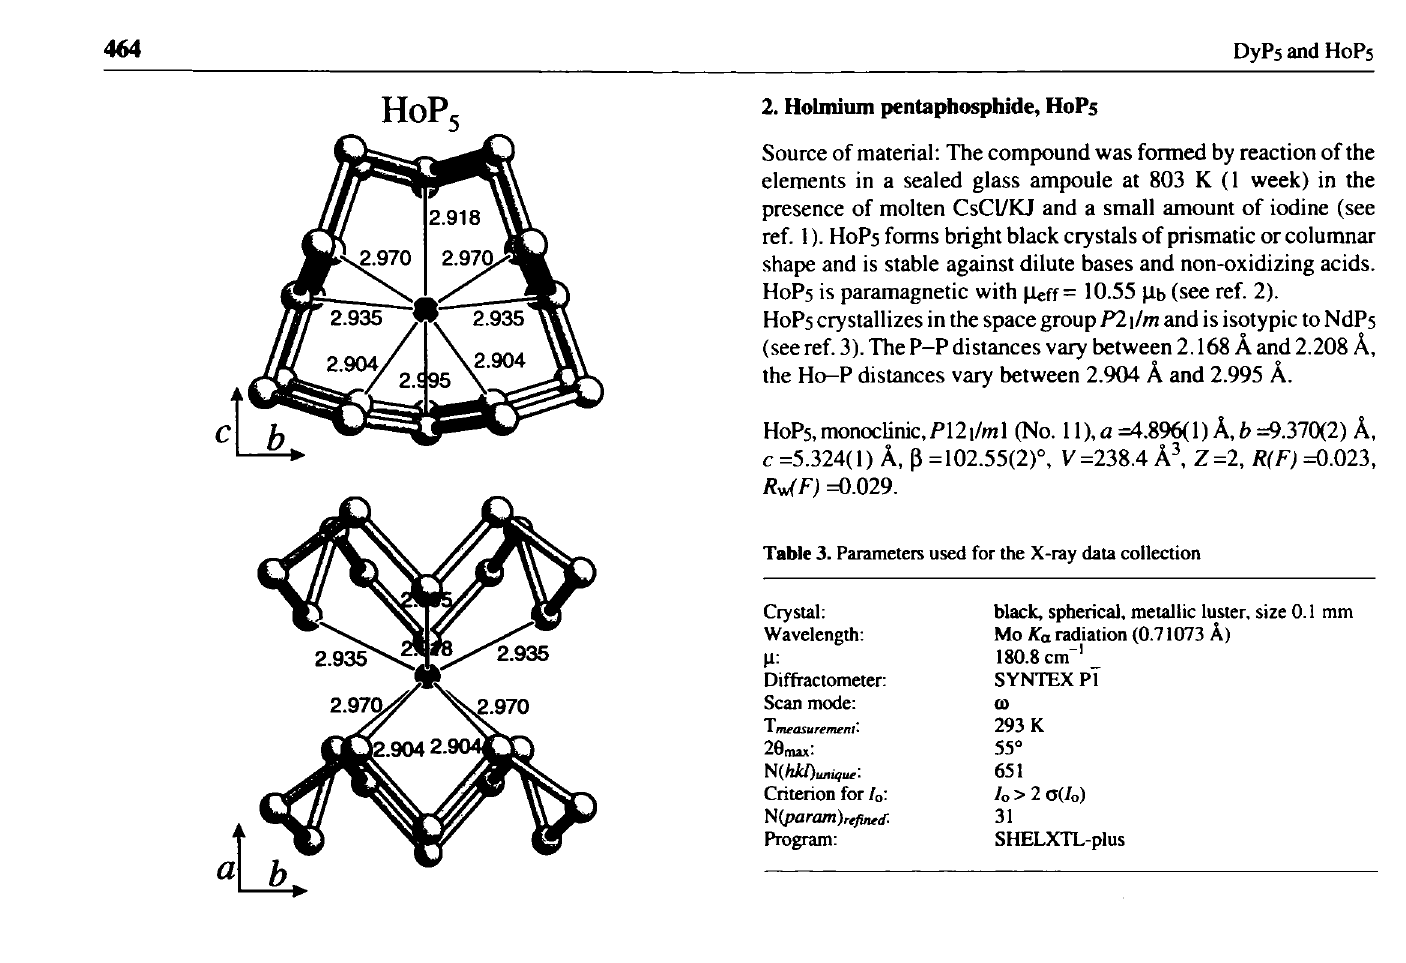
Table 4. Final atomic coordinates and displacement parameters (in Â^)